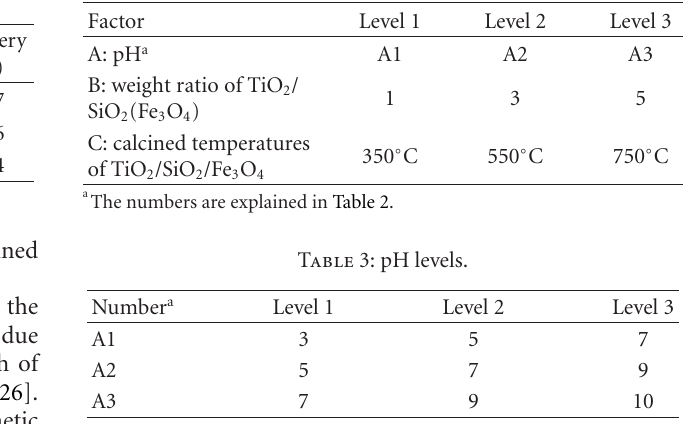
Table 2: Factors and their levels for the experiments.